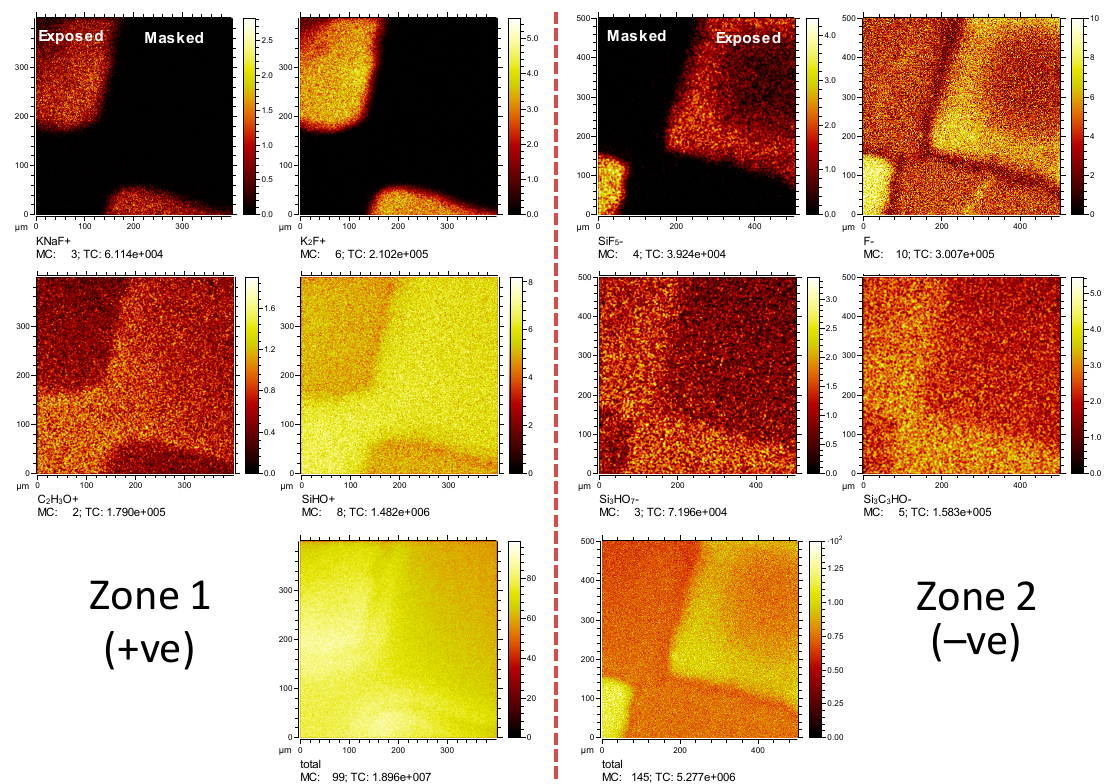
Figure 4. Time of flight secondary ion mass spectroscopy (ToF-SIMS) chemical maps from a micropatterned PSiF surface after PFDS functionalization. Left : KNaF + , K 2 F + , C 2 H 2 O + , SiOH + and total positive ions (from left to right and top to bottom). Right : SiF 5 − , F − , Si 3 HO 7 − , Si 3 C 3 HO − and total negative ions (from left to right and top to bottom).